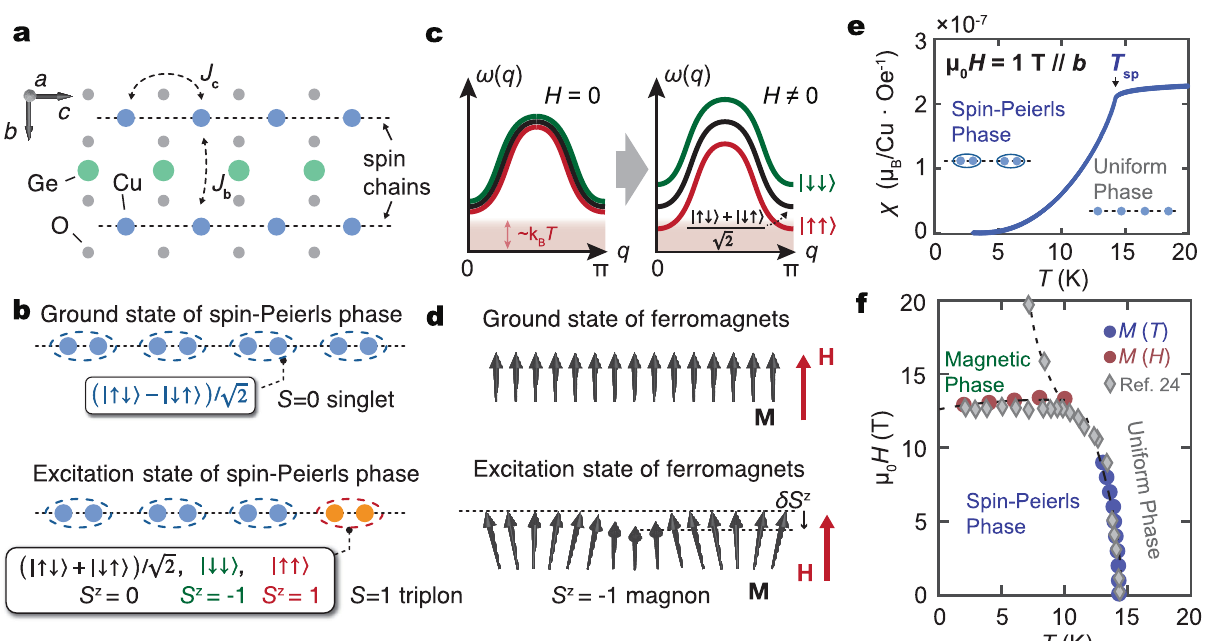
Fig. 1 Spin chain and spin-Peierls (SP) phase of CuGeO 3 . a Crystalline structure of CuGeO 3 . The Cu spin chains are shown as dotted lines. Spin-1/2 spin chains along the c -axis in CuGeO 3 are formed by staking CuO 2 chains. J c and J b denote the exchange interactions along the c and b -axis, respectively. b When temperature ( T ) falls down to the SP transition temperature T SP , CuGeO 3 undergoes a SP transition. After the transition, the Cu spins dimerize and the ground state becomes a spin singlet state ( ð "# band structure of triplon in CuGeO 3 19,21 . Three triplet states ( ## magnetic fi eld ( H ), the Zeeman effect lift the degeneracy. d The ground state and excitation state of a ferromagnet. Elementary excitation is a magnon with S = 1. The magnons reduce the magnetization ( M ) along the magnetic fi eld ( H ) as δ S z . e T dependence of magnetic susceptibility ( χ ) of CuGeO applied magnetic fi eld of 1 T along the b -axis. The SP transition temperature T SP is illustrated as the arrow in the fi gure. f Magnetic fi eld - temperature ( H - T ) spin phase diagram for the CuGeO previous study 24 . The dotted curves are guide for the eyes.